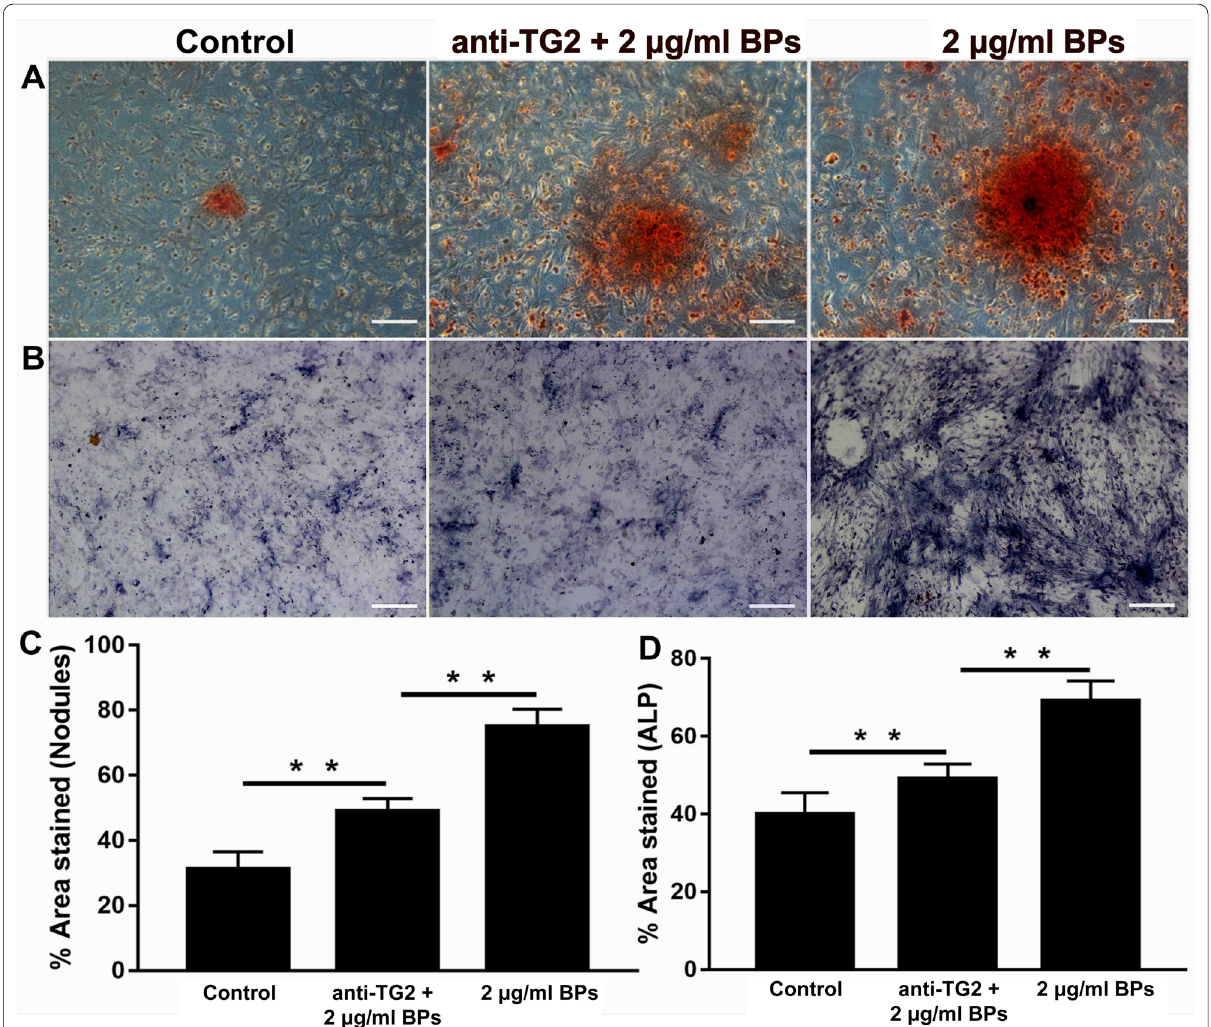
Fig. 8 Osteogenic differentiation of EMSCs with TG2 neutralizing antibody. A ALP staining. B ARS staining performed to examine extracellular mineralization. C Quantitative ALP analysis. D Quantitative Alizarin red staining analysis. ** p <